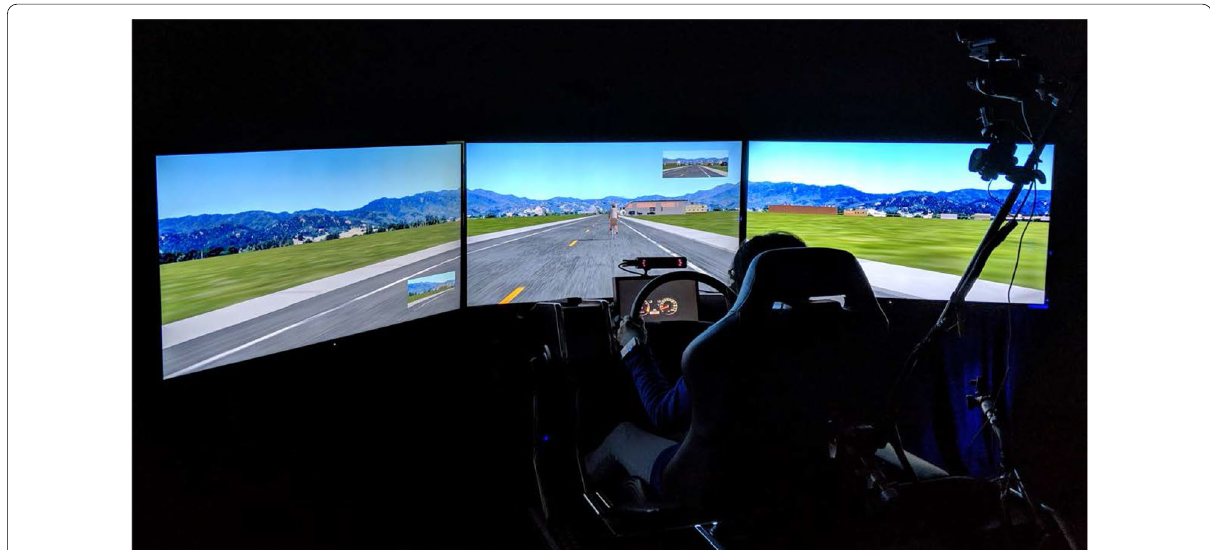
Fig. 1 Driving simulator apparatus. *This figure was published in Goddard et al. (2020), Copyright Elsevier 2020. Reprinted with